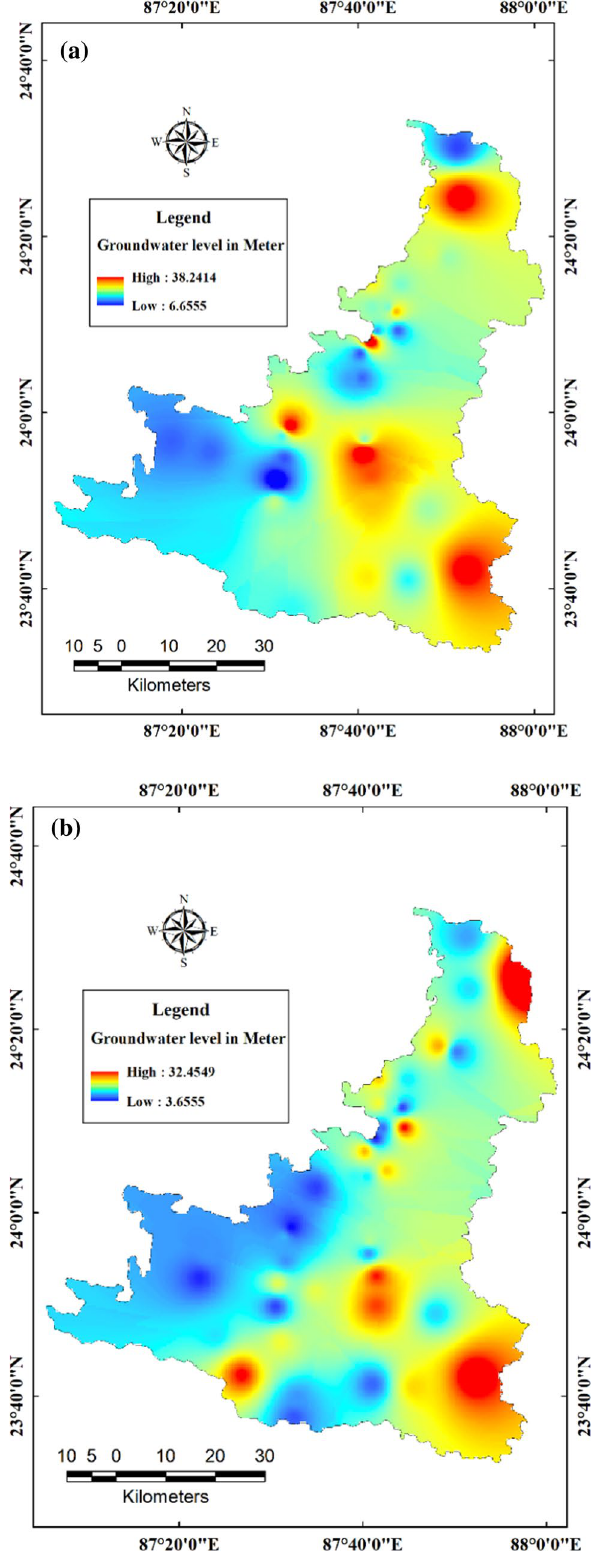
Fig. 24 a Pre-monsoon groundwater level of 2030. b Post-monsoon groundwater level of